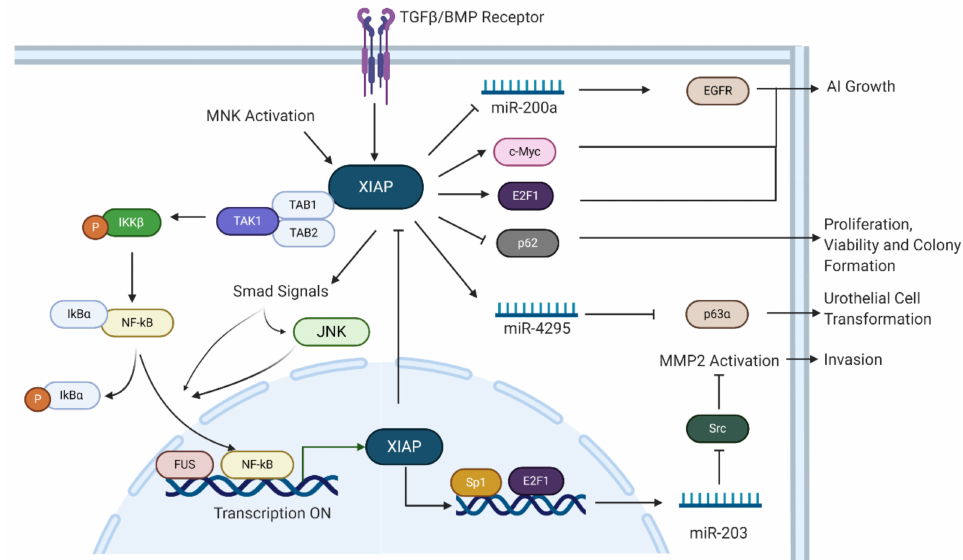
Figure 3. XIAP Signaling Pathways in Human Cancer. XIAP senses external signals through TGF β and bone morphogenetic proteins (BMP) receptors. MNK activation and RPS3 (ribosomal protein